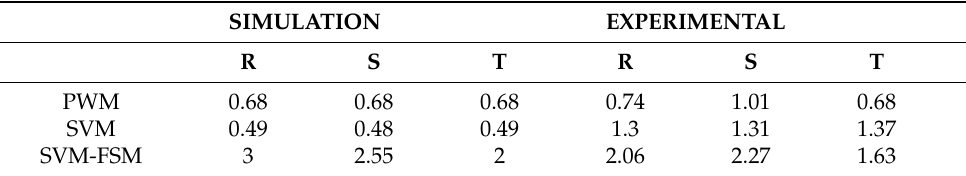
Table 8. THD (%), f sw = 1500 Hz.